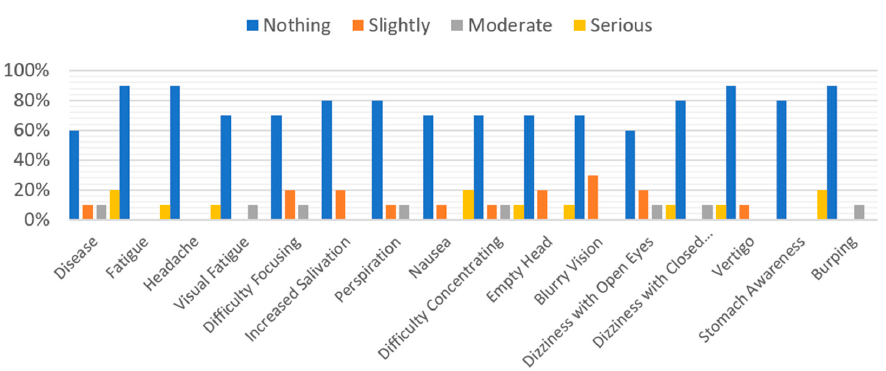
Figure 8. Simulator Sickness. Figure 8 . Simulator Sickness.